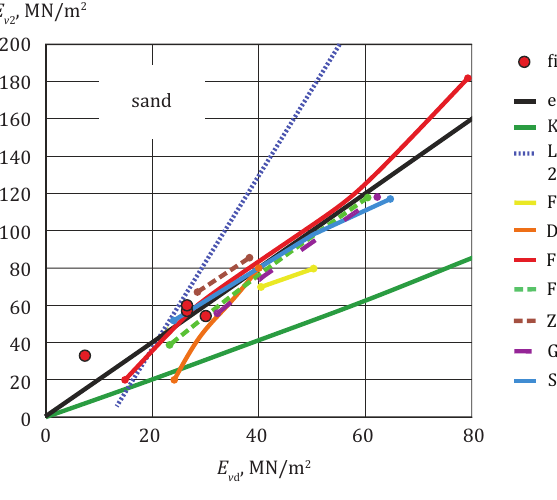
Figure 5. Correlations for sand